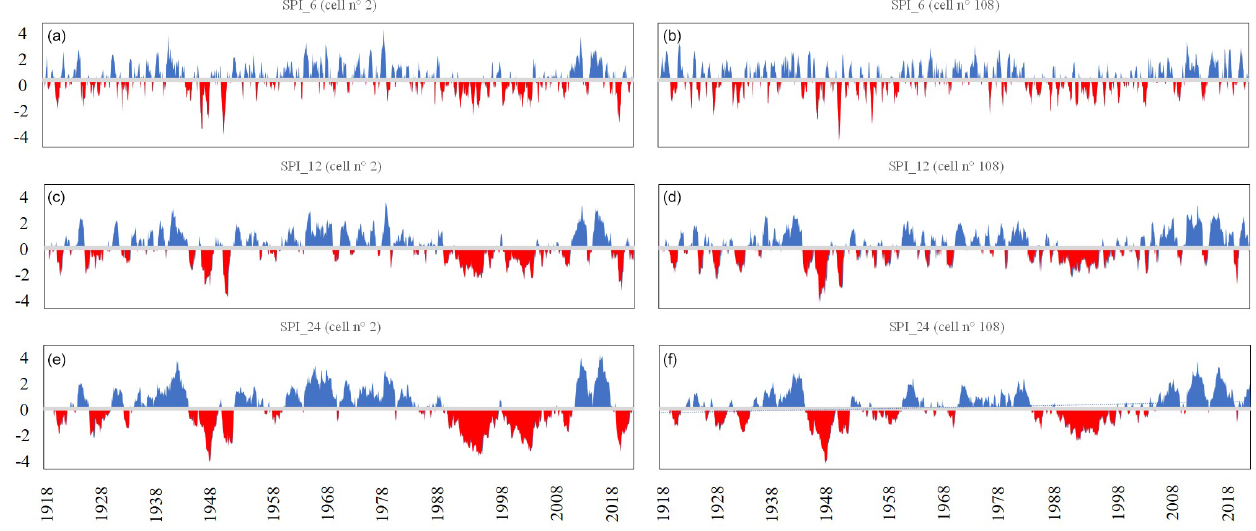
Figure 3. SPI_6, SPI_12 and SPI_24 for cell no. 2 (southern area – a , c , e ) and cell no. 108 (northern area – b , d , f